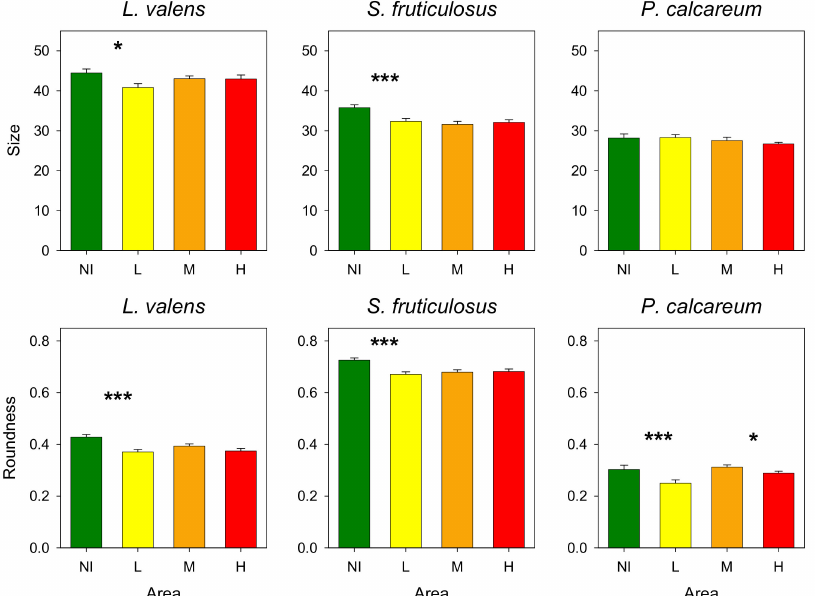
Figure 8. Mean values and standard errors of size (mm) and roundness for the three species of rhodoliths, estimated from beam trawl samples in the four areas considered: Non-impacted (NI), Low effort history (L), Medium effort history (M), and High effort (H). p -values of the Student’s t -test to test for differences between areas are presented. * p < 0.05; ** p < 0.01; *** p < 0.001.